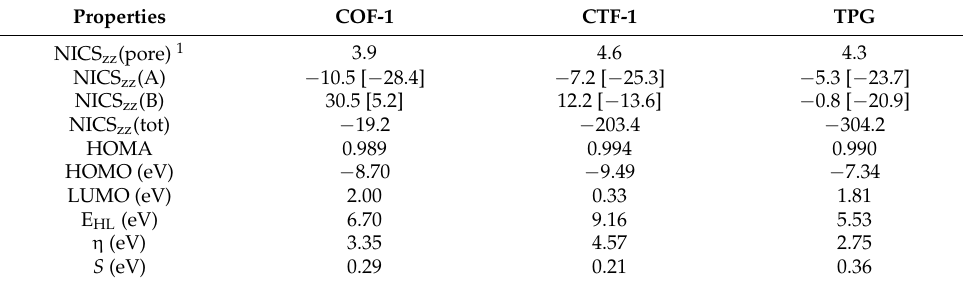
Table 1. Aromaticity and stability indexes for three